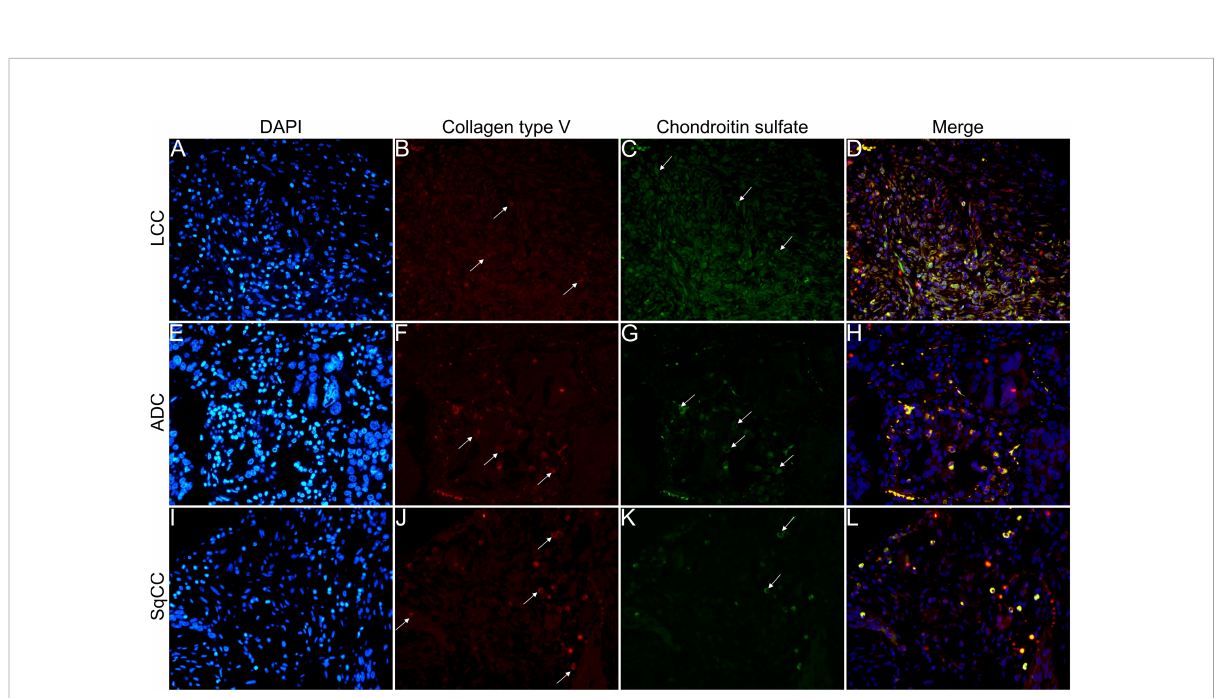
FIGURE 9 Co-analysis of immuno fl uorescence of chondroitin sulfate (green; C , G , K ) and collagen type V (red; B , F , J ) in three different histological subtypes of non-small cell lung carcinoma (N=120). The stained nuclei are represented in blue (DAPI; A , E , I ). Images D , H , L represent the merge of the same fi eld of these three stains. White arrows indicate positive expression of the markers. Original magni fi cation: 40x. LCC, large cell carcinoma; ADC, lung adenocarcinoma; SqCC: lung squamous cell